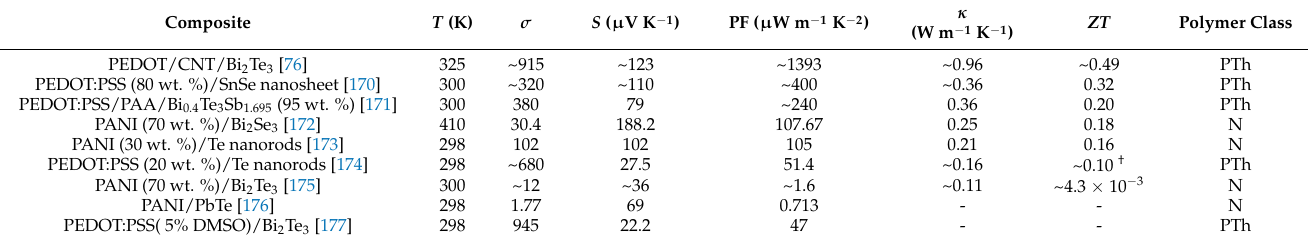
Table 7. Thermoelectric properties of representative conventional/polymer composites at a stated temperature ( T ). PAA = poly(acrylic acid). σ is electrical conductivity, S is the Seebeck coefficient, PF is the power factor, κ is the thermal conductivity, and ZT is the figure of merit. † Calculated from literature